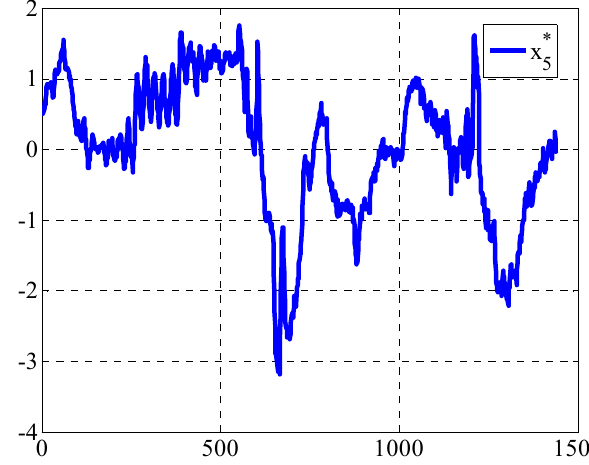
of leakage rate of air preheater (2# boiler). 5